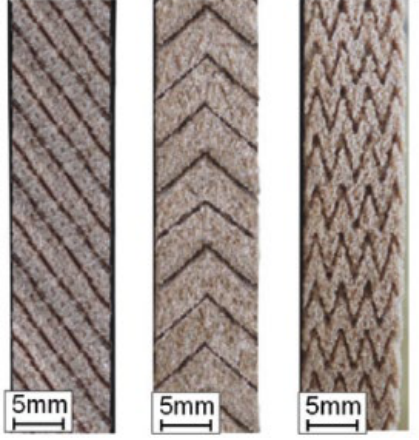
Figure 20. Grooves produced by the AWJ method